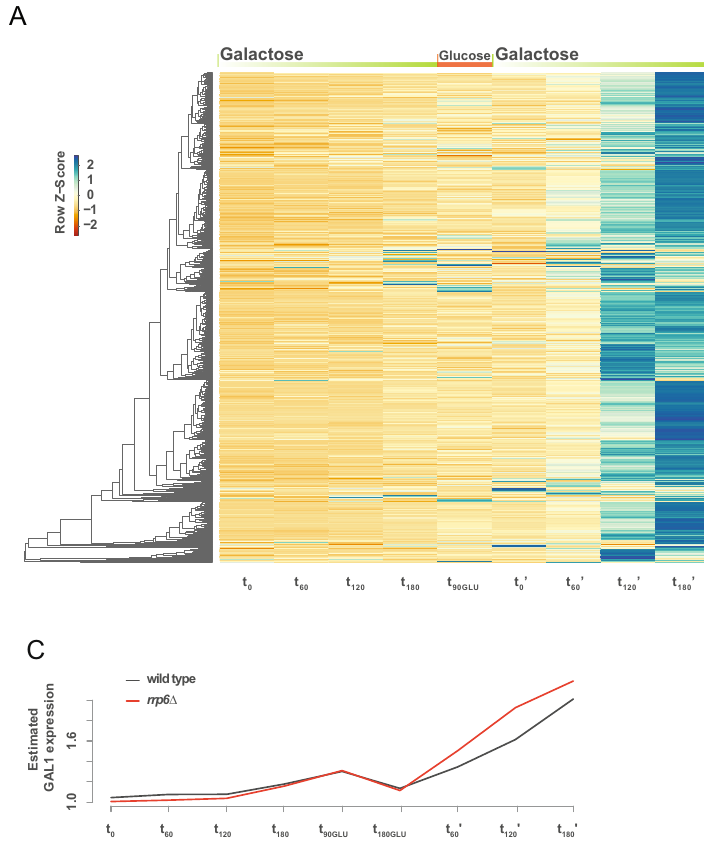
Fig. 1 | Screen for genetic factors controlling transcriptional memory. A Heatmapdepicting strain-speci fi cz-cores for pGAL1-sGFP expressionatdifferent time points. Green refers to high sfGFP expression (see Supplementary Data 1 and methods for detail). B Top 19 candidate deletion strains displaying enhanced transcriptionalmemory.Lines represent known interactions ascurated by STRING v11.5 48 .blue indicate from curated databases, pink indicate experimentally